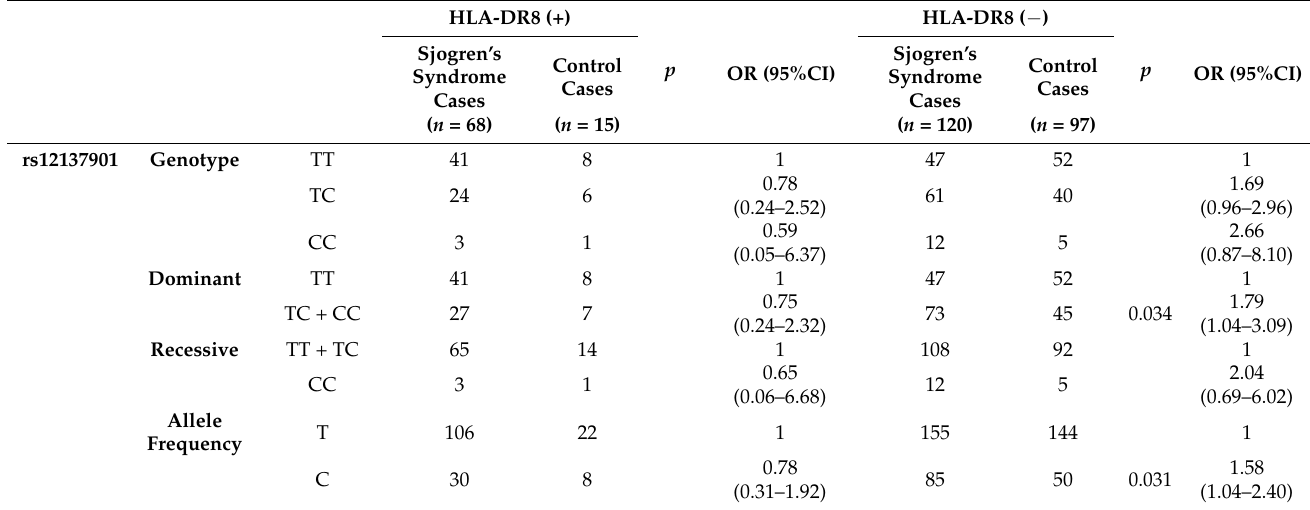
Table 3. Genotypes and allele frequency of NLRP3 gene in HLA-DR8 pSS patients.